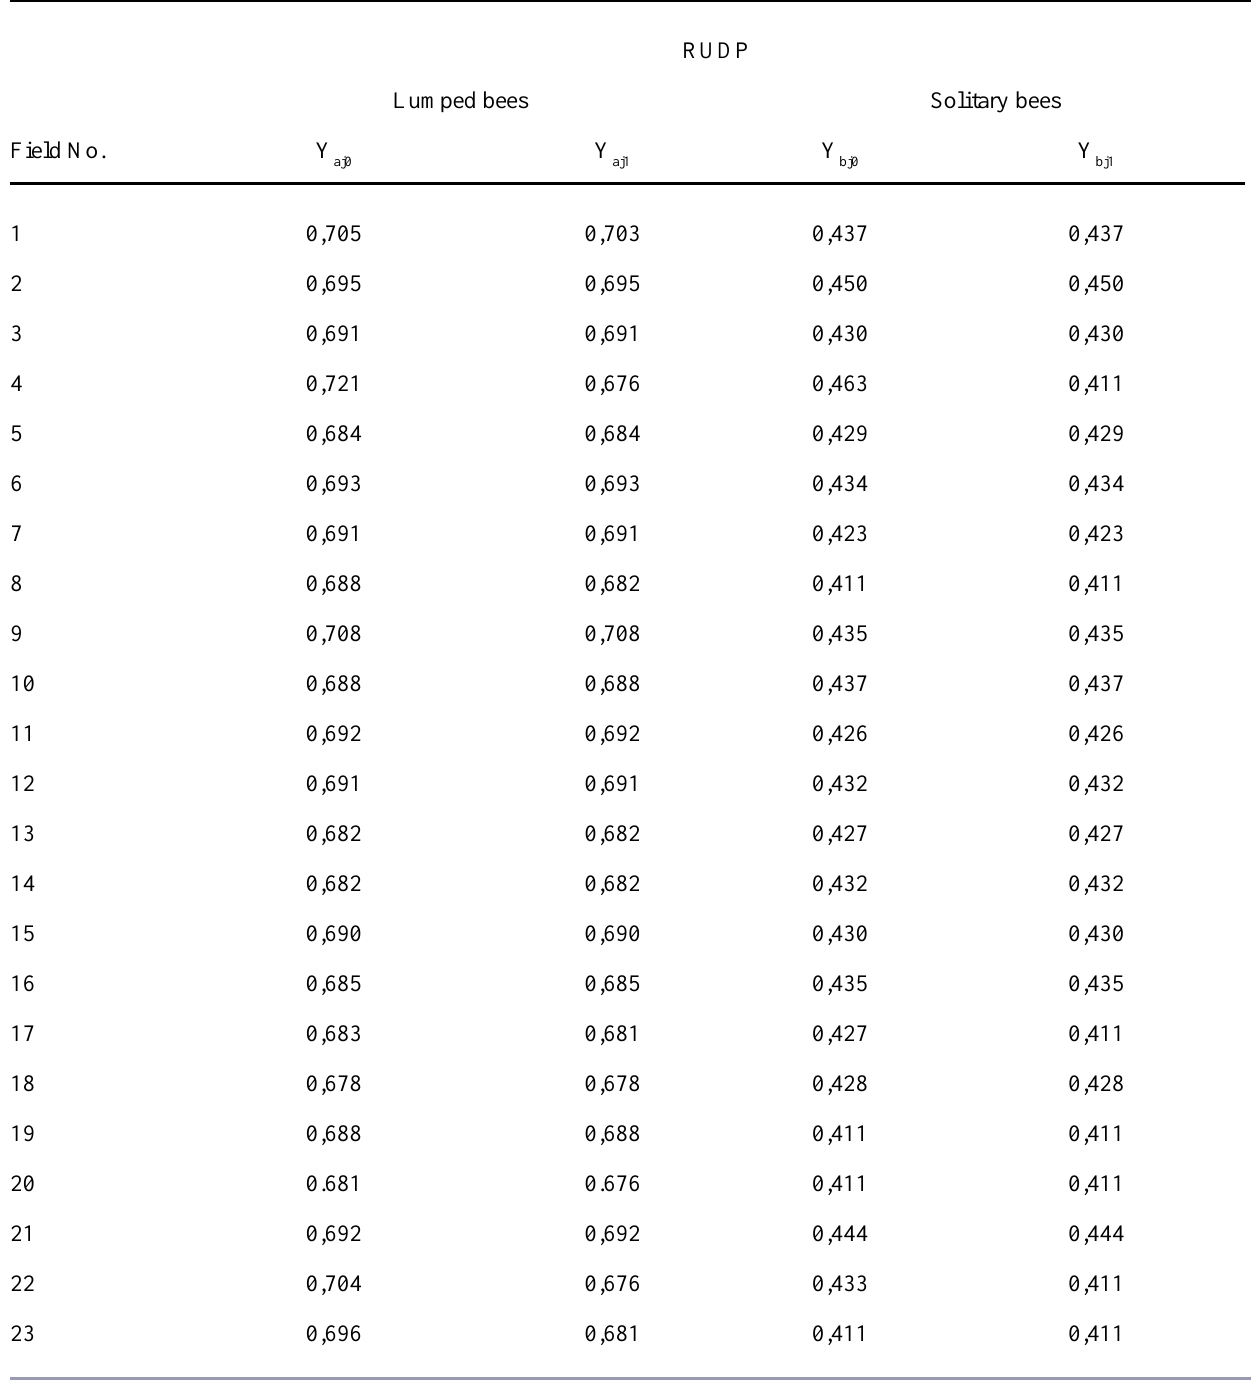
Table 2 . Number of bees per square meter before (t=0) and after (t=1) the implementation of the Regional Urban Development Plan (RUDP) under the non-pollinated crop scenario. “Lumped bees” indicates both generalists and solitary bees together in the functional group.